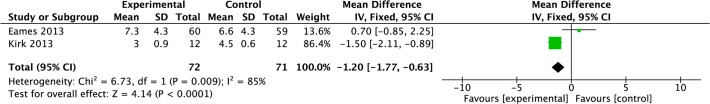
Forest Plot: Anxiety.